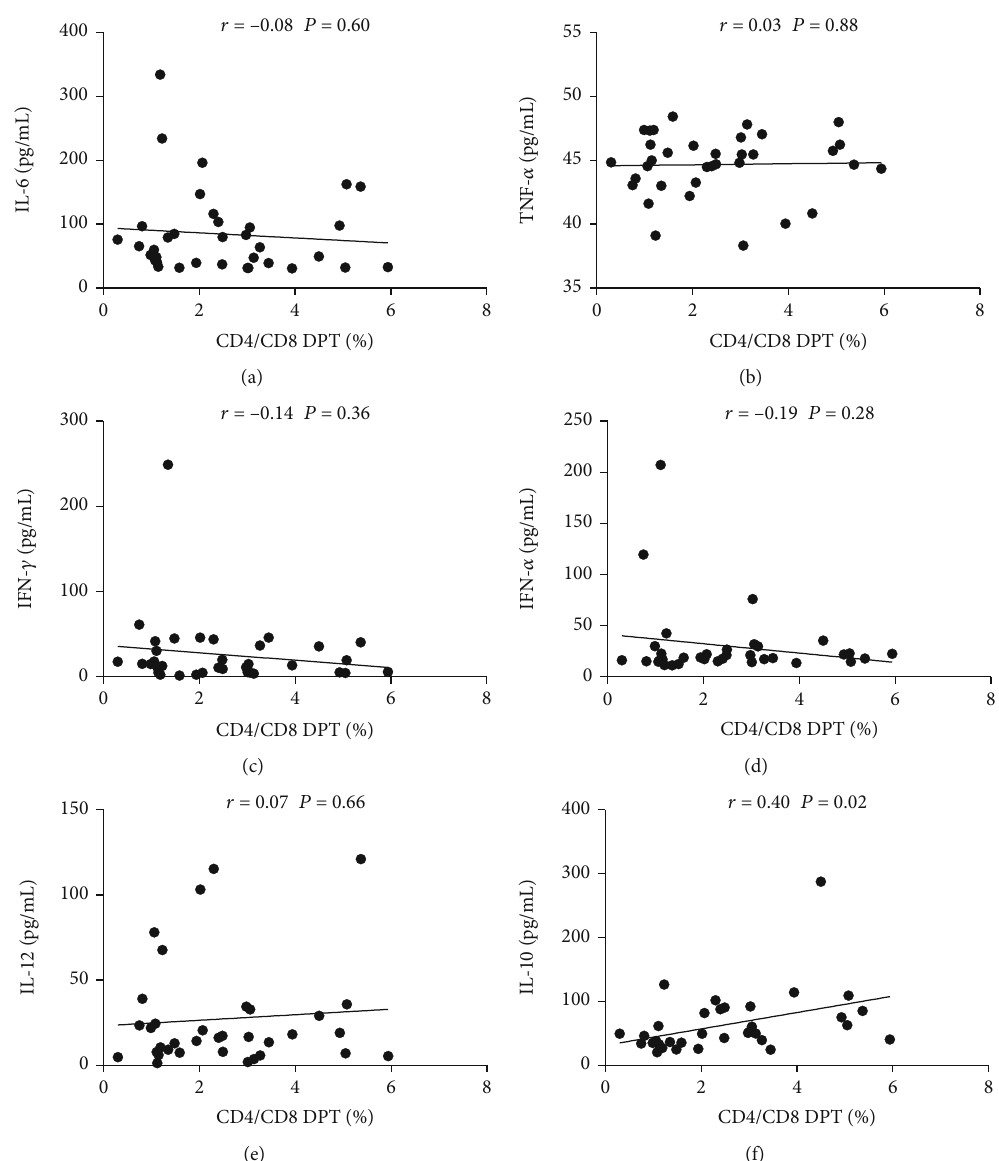
Figure 4: Correlation analysis between the frequency of peripheral DPT cells and IL-6, TNF- α , IFN- γ , IFN- α , IL-12, and IL-10 (a – f).